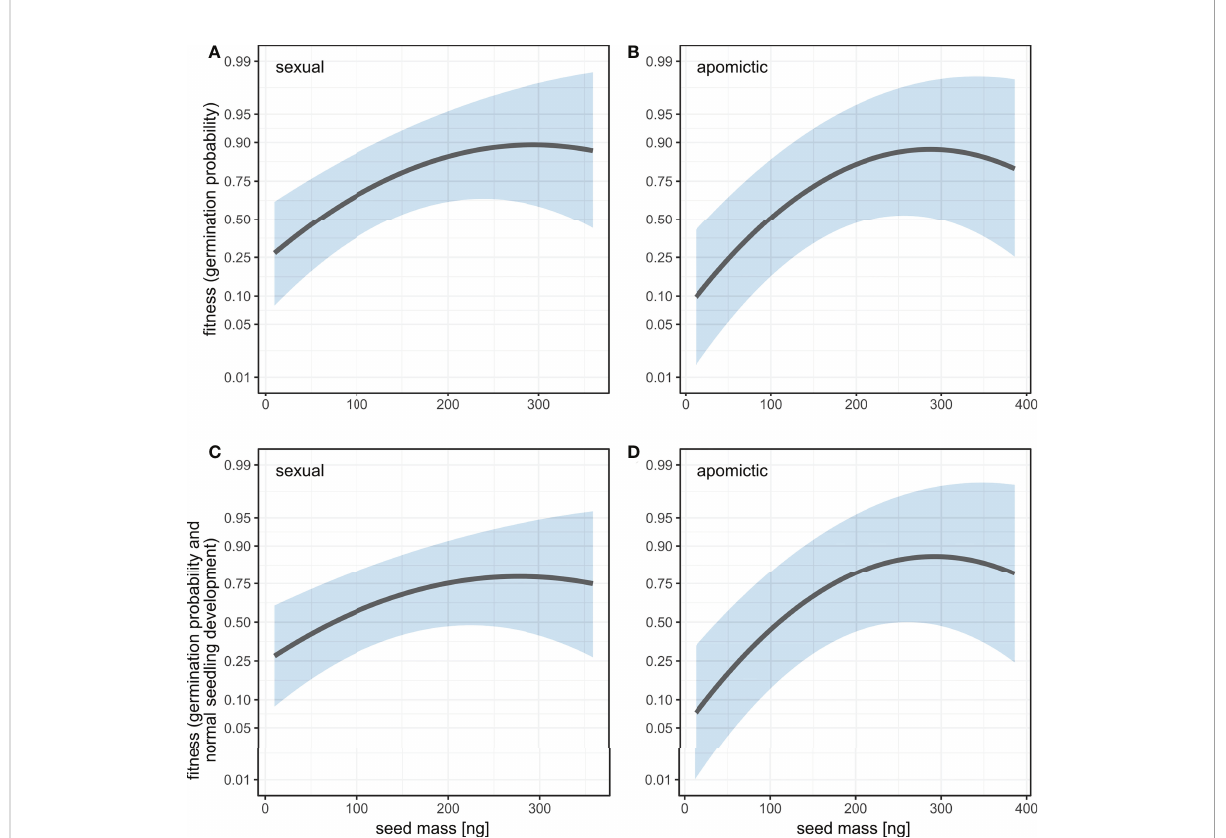
FIGURE 7 Fitness as a function of seed mass estimated using univariate linear and quadratic selection gradients for two fi tness measures: germination probability (A, B) and a composite measure of germination probability and normal seedling development (C, D) in sexual (A, C) and apomictic (B, D) accessions. Fitness is plotted on logit scale. Shaded areas represent 95% con fi dence